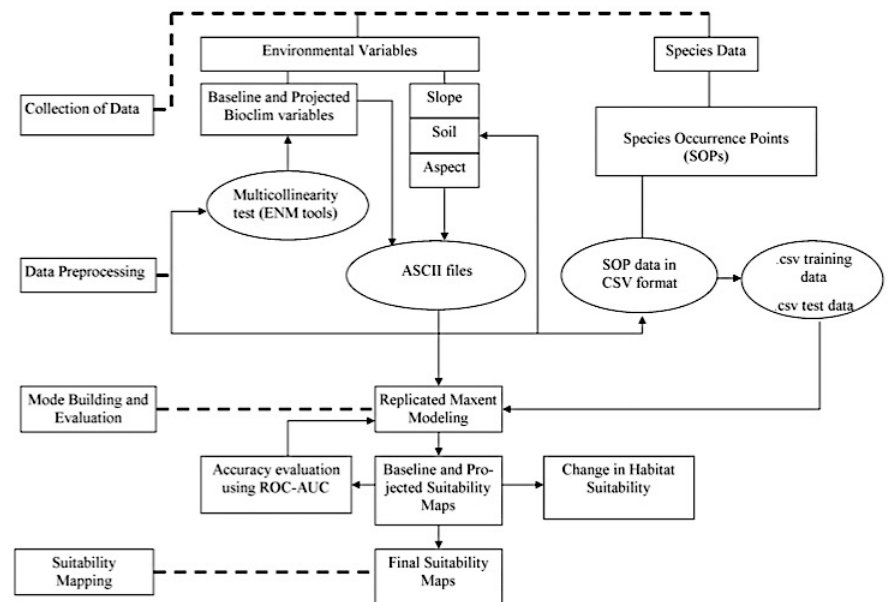
Fig. 4: Conceptual summary of modeling method